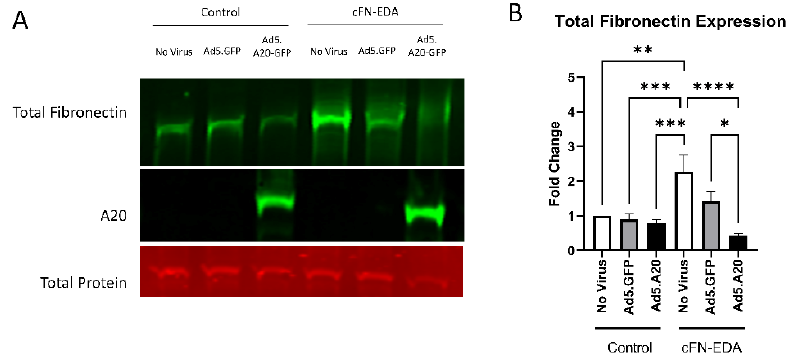
Figure 6. cFN-EDA-induced fibronectin expression is attenuated with A20 overexpression. Primary TM cells were treated with the indicated Ad.5 virus and then with cFN-EDA for 48 h. ( A ) Representative Western blot showing fibronectin and A20 expression, with the total protein stain used for normalization. ( B ) Fibronectin expression was greatly induced by the addition of cFN-EDA, and A20 overexpression blocked cFN-EDA-induced fibronectin expression. Statistical significance was calculated by one-way ANOVA with Tukey post-hoc analysis, with p < 0.05 considered statistically significant. Error bars show SEM. * = p ≤ 0.05, ** = p ≤ 0.01, *** = p ≤ 0.001, **** = p ≤ 0.0001.